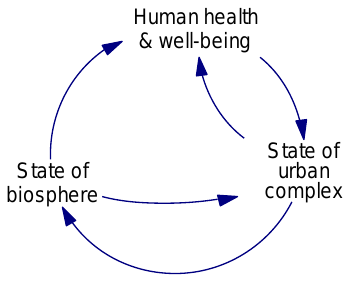
Figure 1. The Co-Effects Template.